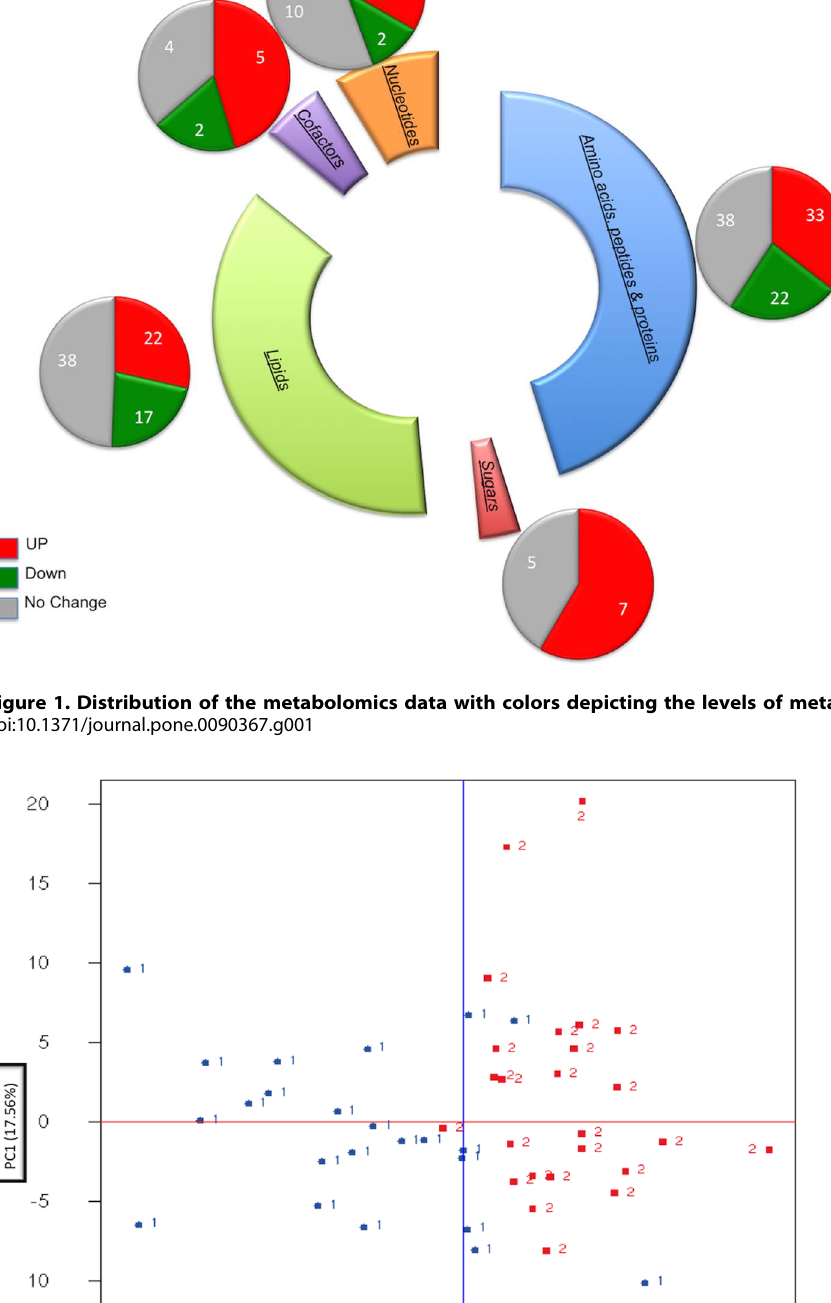
PLOS ONE | www.plosone.org